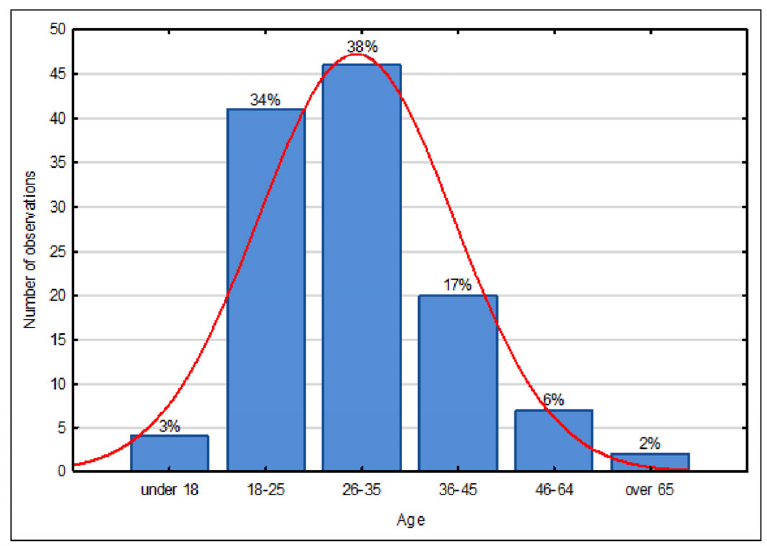
Figure 7. Histogram of the age of respondents. Source: own study based on questionnaire surveys.